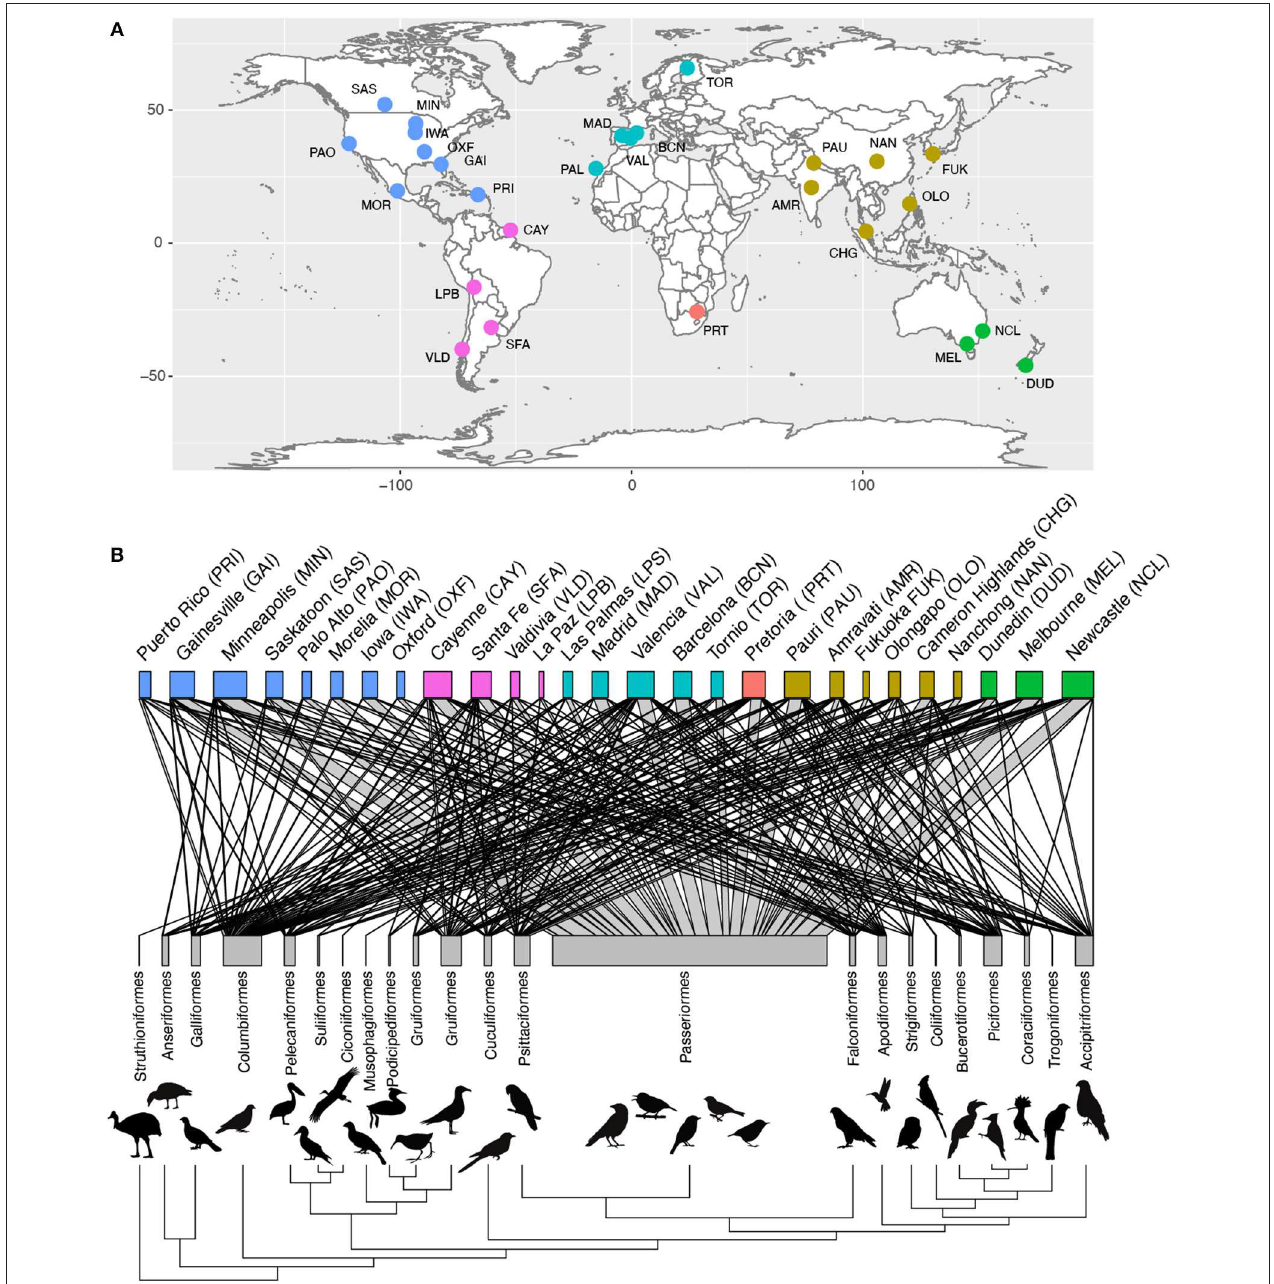
FIGURE 1 | Geographical and taxonomic coverage of the data. Our study includes abundance data from 27 cities from all the continents (A) . Abundance and brain size data was available for 629 species from 23 orders of birds including 1,036 unique city × species records. In (B) the distribution across cities of species from each taxonomic order are represented in a network, where the width of the links indicates the number of species from each order occurring in each city and the width of the bars indicates the total number of species in each city (top) and order (bottom). Silhouettes for each order are available at phylopic.org under a public domain